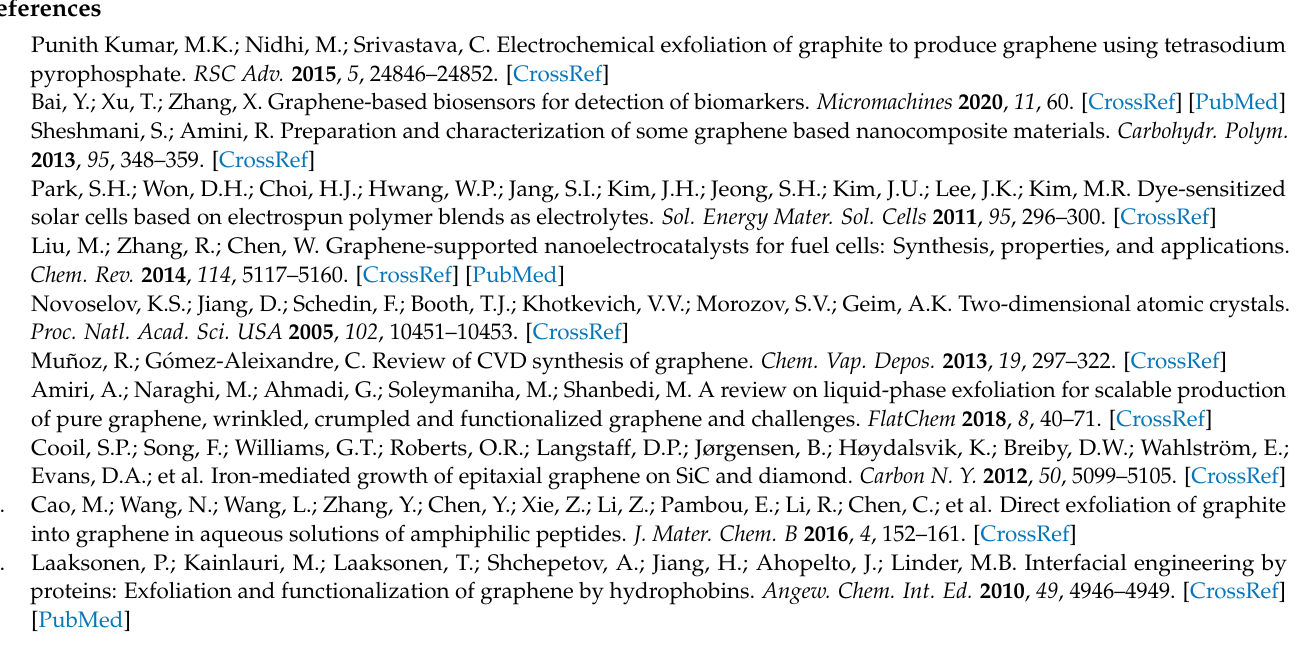
Figure S2: EDX spectrum of the tri-enzymatic system immobilized on bio-Graphene; Figure S3: SEM image (top left panel), and EDX mapping of C (middle left panel), O (middle right panel), N (bottom left panel) and P (bottom right panel) as well as overlay (top right panel) of the maps of a flake of tri- enzymatic system immobilized on bio-Graphene; Figure S4: Stability of free and co-immobilized GOx and HRP on bio-Graphene: residual activity after incubation at 37 ◦ C for different times; Figure S5: Stability of free and co-immobilized GOx, HRP, and bgl on bio-Graphene: residual activity after incubation at 50 ◦ C for different times; Figure S6: Schematic presentation of the cascade reaction of p NPG and cellobiose hydrolysis to ABTS + , catalyzed by the tri-enzymatic nanobiocatalyst; Figure S7: Time-dependent increase in absorption intensity at 745 nm for the cascade reaction of p NPG hydrolysis to ABTS + , catalyzed by the tri-enzymatic nanobiocatalyst at (a) 25 ◦ C, (b) 30 ◦ C, (c) 40 ◦ C, and (d) 50 ◦